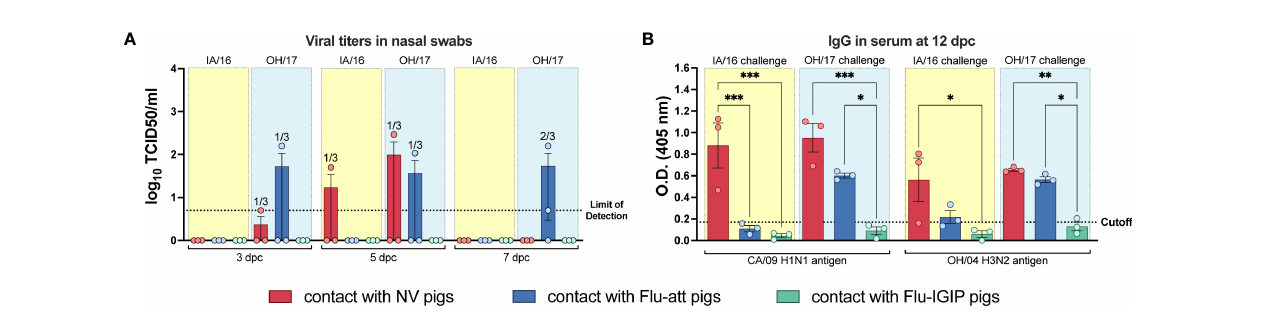
FIGURE 6 Respiratory transmission from challenged pigs to naïve contacts. Non-vaccinated pigs (NV, red bars) or pigs vaccinated with bivalent Flu- att (blue bars) or Flu-IGIP (green bars) were challenged with A/swine/Iowa/A01778877/2016 (IA/16 H1N1, light-yellow boxes) or A/swine/Ohio/A01354299/2017 (OH/17 H3N2, light-blue boxes). Naïve pigs (n=3/group) were placed in the same room as challenged pigs but with no direct contact at 2 days post inoculation (dpi). (A) Viral titers in nasal swabs were measured by TCID 50 at 3, 5 and 7 days post contact (dpc) and (B) IgG antibody titers were measured in serum by ELISA at 12 dpc. Viruses on the x-axis of (B) represent antigens used in the ELISA: CA/09, A/California/04/09 H1N1; OH/04, A/turkey/Ohio/313053/2004 H3N2. *, p ≤ 0.05; **, p ≤ 0.01; ***, p ≤ 0.001 within groups challenged with the same virus. Dotted lines indicate limit of detection for titration or ELISA cutoff values calculated as the average of negative pigs + 3 times the standard error of the